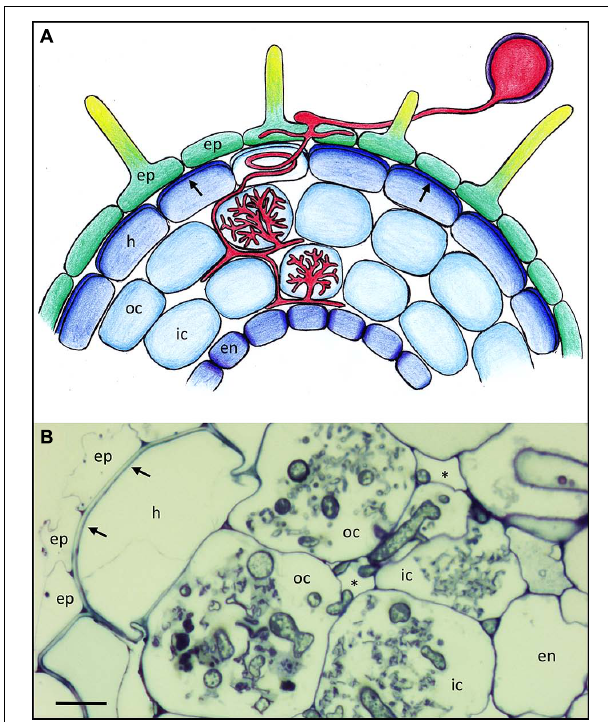
FIGURE 1 | Basic root anatomy and colonization pattern of the arbuscular mycorrhizal fungus Rhizophagus irregularis in Petunia hybrida . (A) Schematic representation of a Petunia root with the different cell types and with an AM fungus (red). Arrows point to the reinforced outer cell wall of the hypodermis. Lighter coloration of the penetrated cell signifies a hypodermal passage cell. (B) Cross section of a mycorrhizal Petunia root. Arrows indicate the thick outer cell walls of the hypodermis. Asterisks indicate the intercellular air space between cortical cells. Fungal colonization is visible only in the cortex. ep, epidermis; h, hypodermis; oc, outer cortex; ic, inner cortex; en, endodermis. Size bar 10 μ